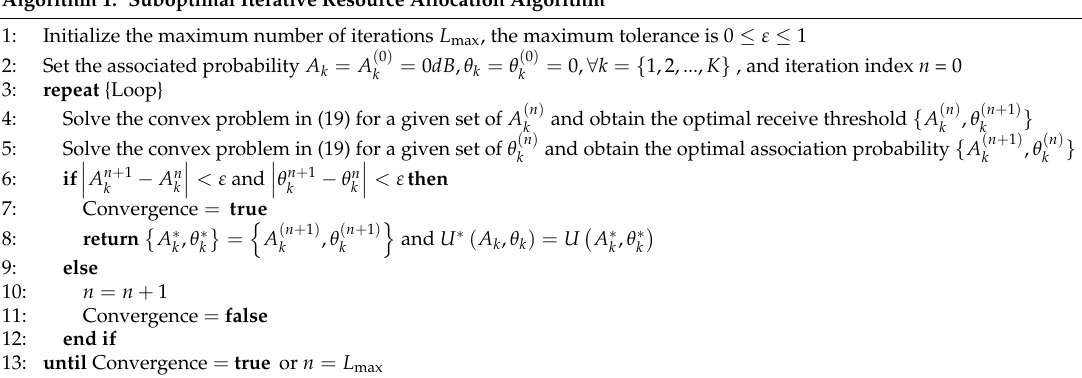
Algorithm 1. Suboptimal Iterative Resource Allocation